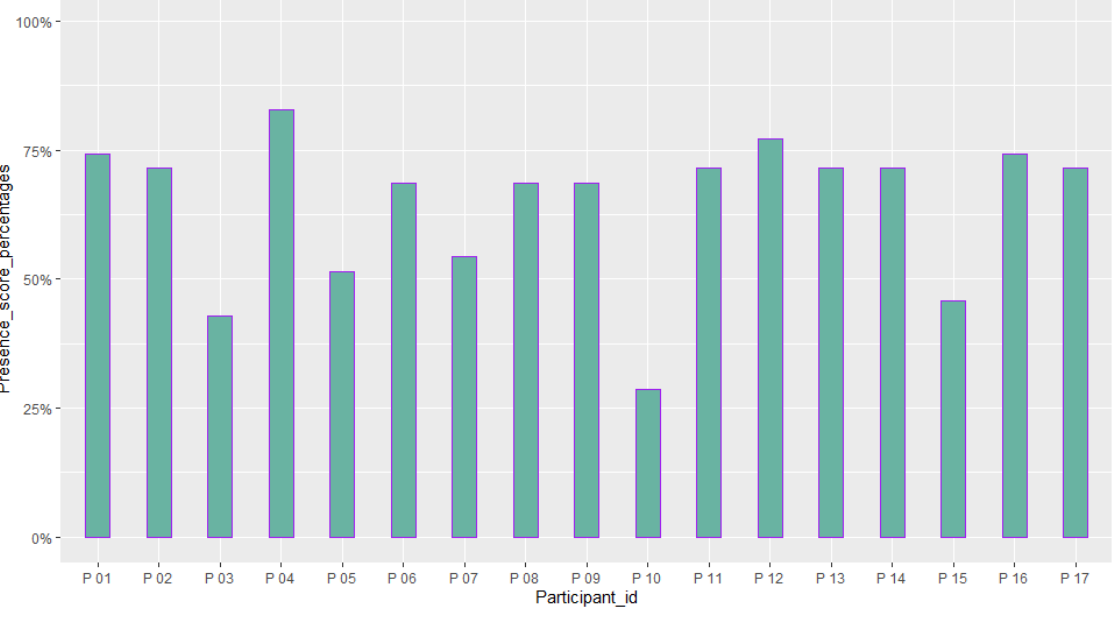
Figure 18. A comparison between the scores obtained from the participants from the Slater–Usoh– Steed presence (SUS) questionnaire (M = 64.37 (%), SD = 14.50